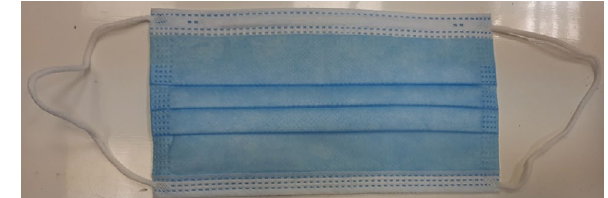
Figure 1. Ear loop facemask used in the current